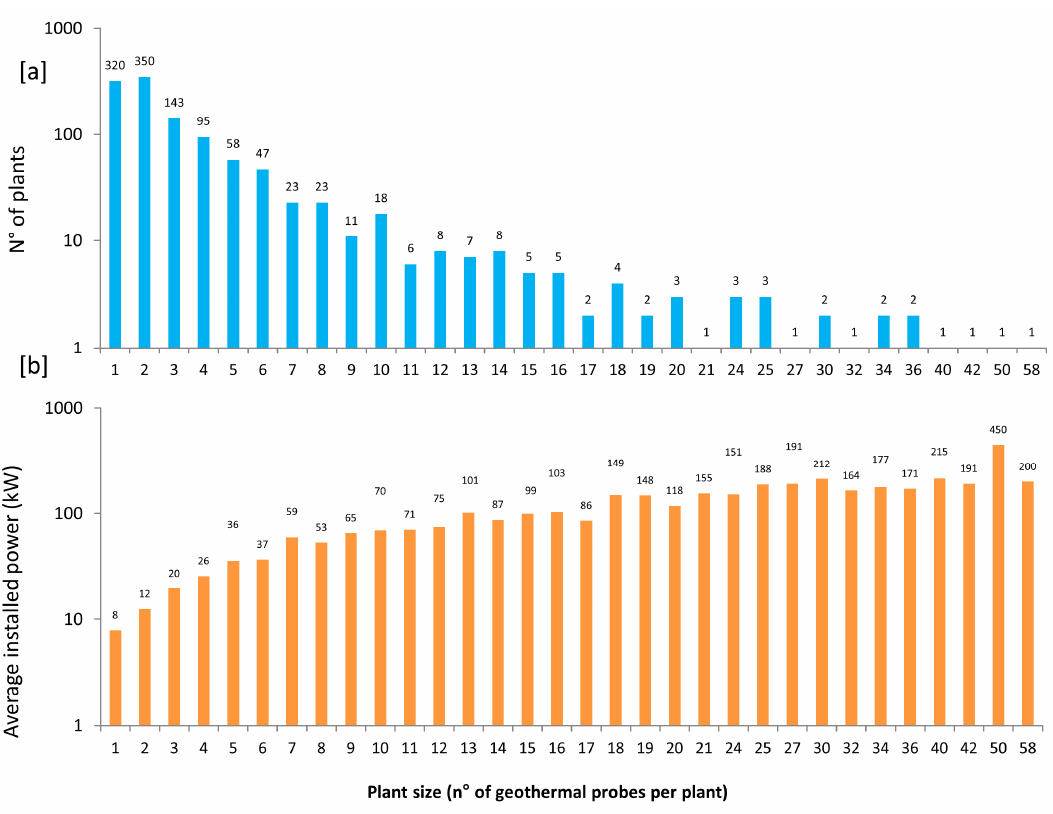
Figure 2. Basic statistics for Cantone Ticino geothermal systems: ( a ) amount of systems per size class; ( b ) average installed power per size class. Table 1. Reference table for the exploitation of heat from ground and subsurface in Switzerland. Type of System üB Au Zu Area S3 S2 S1 Geothermal probes (vertical systems) + b − − − − Underground circuits (horizontal systems) + + 4 −